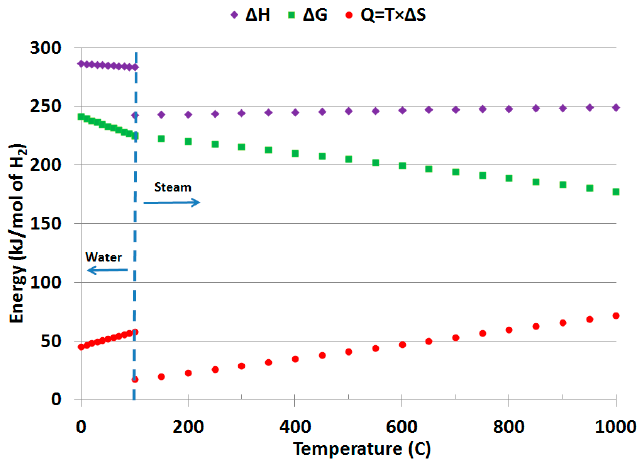
Figure 2. Theoretical energy demand for electrolysis as a function of the reaction temperature.